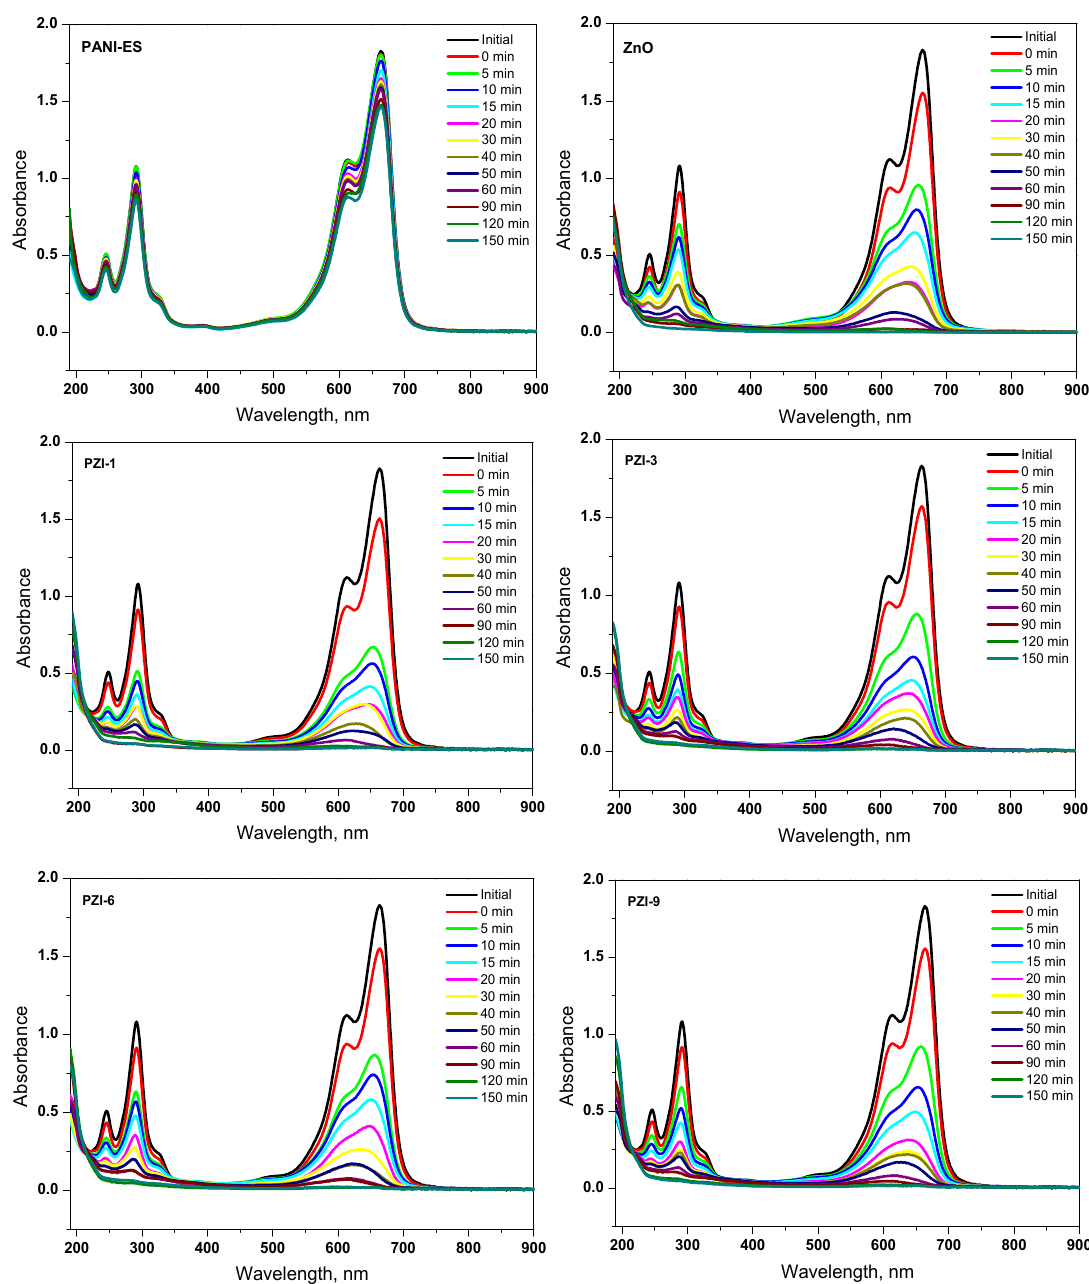
Figure 7. Ultraviolet-visible (UV-vis) absorption spectra of methylene blue (MB) using PANI-ES, ZnO and PZI composites. The underlying mechanism of photocatalytic degradation of MB was presented by Lin and colleagues revealing various intermediates and final products initiated by sole attack of hydroxyl radical directly to the N-S- conjugated linkage of the aromatic sub-groups. The plausible pathway was explained by irradiation time dependent formation and successive removal of substances defined by ESI-MS m / z values primarily as C 8 H 11 N 2 SO 3 and C 8 H 12 N 2 . Upon further irradiation periods, C 6 H 4 NSO 5 , C 6 H 6 SO 3 , C 6 H 10 O 2 , C 8 H 11 NO and C 6 H 6 O 2 were formed which were also degraded to C 3 H 6 O 2 and C 3 H 4 O 4 [60]. Upon use of the specified specimens, considering the hydroxyl radical as the main oxidative species a similar mechanism could be expected. Each of these compounds could also contribute to the UV-vis spectral features under continuously and simultaneously operating formation and removal pathways during